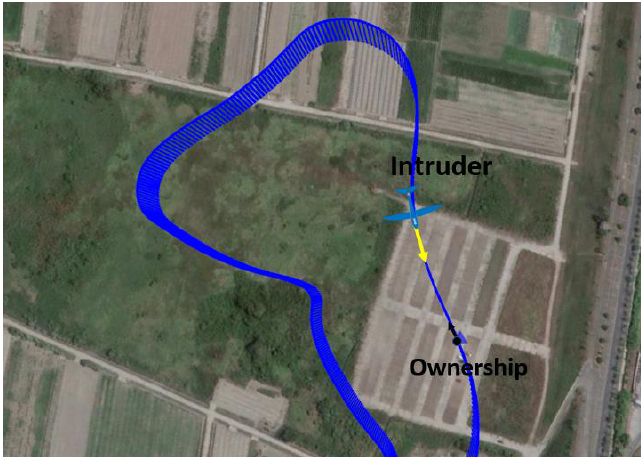
Figure 20. Flight path of the intruder in Experiment 1.